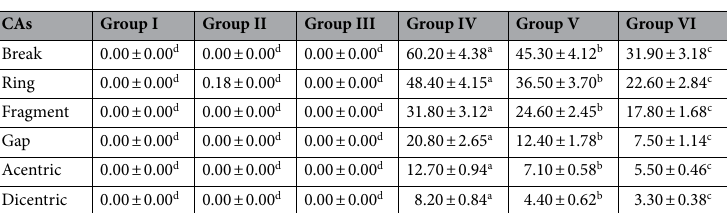
Table 2. The effect of AFM 1 and t-rsv administration on CAs frequency in bone marrow cells. Values are shown as mean ± SD (n = 6). 600 cells were analyzed for chromosomal damage. The means indicated by different letters (a–d) on the same line are statistically significant (p <